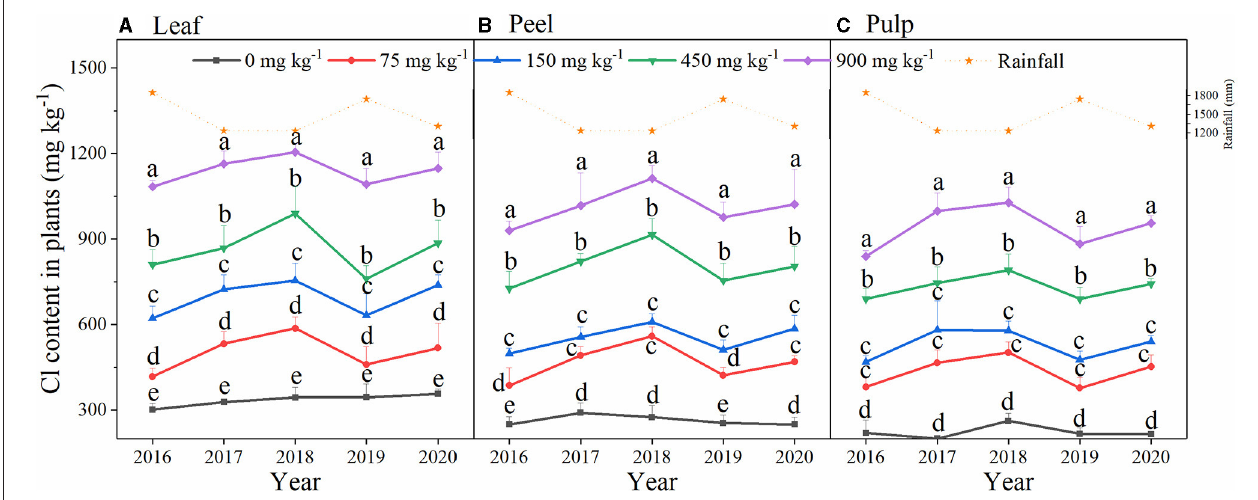
FIGURE 3 | The content of chloride in leaf (A) , peel (B) , pulp (C) in a five-year field experiment from 2016 to 2020. Bars are means of three replicates ± SD. Different letters (a, b, c, d, e) in each sub-figure represent significant differences at ( P < 0.05).